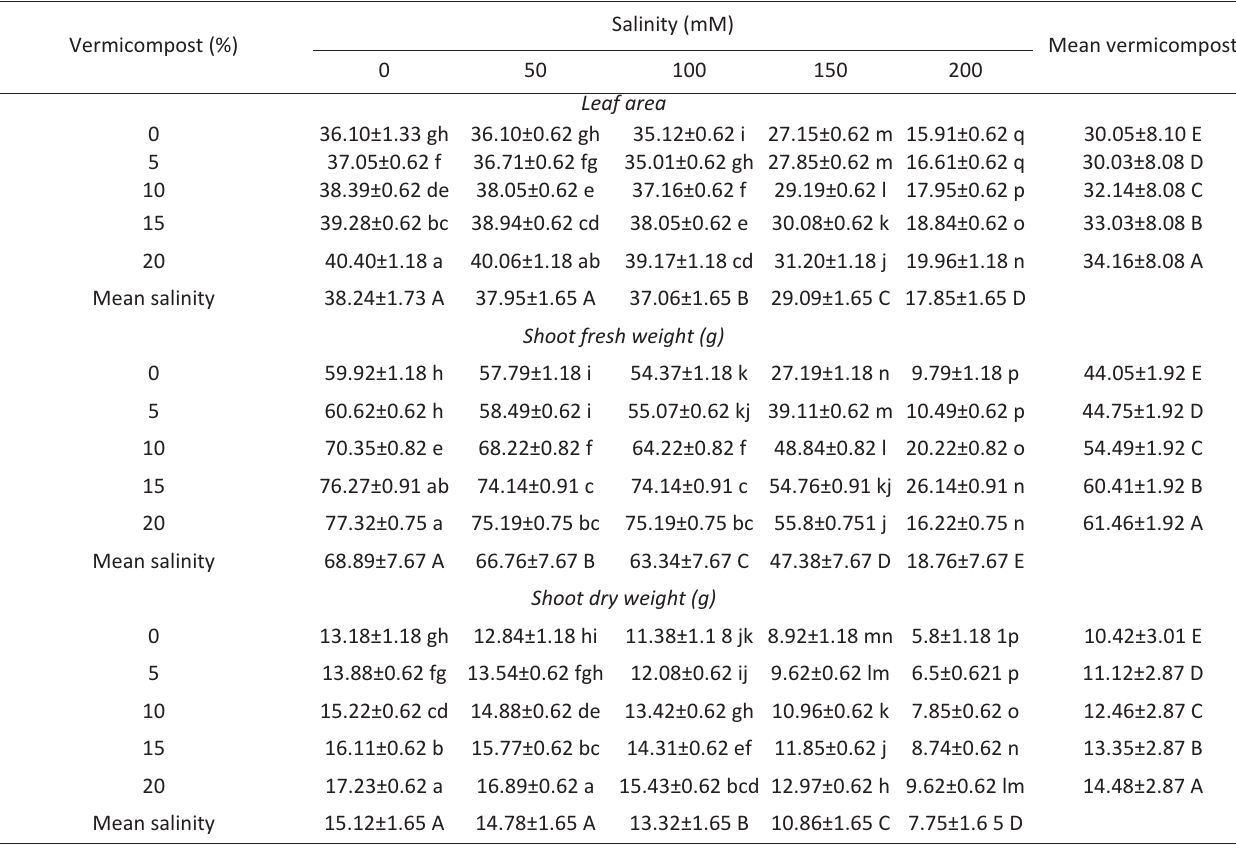
* In each variable, data followed by the same letters (small letters for interactions and capital letters for means) are not significantly dif- ferent using LSD at 5% level. Data represent the mean value ± S.D. the mean of four